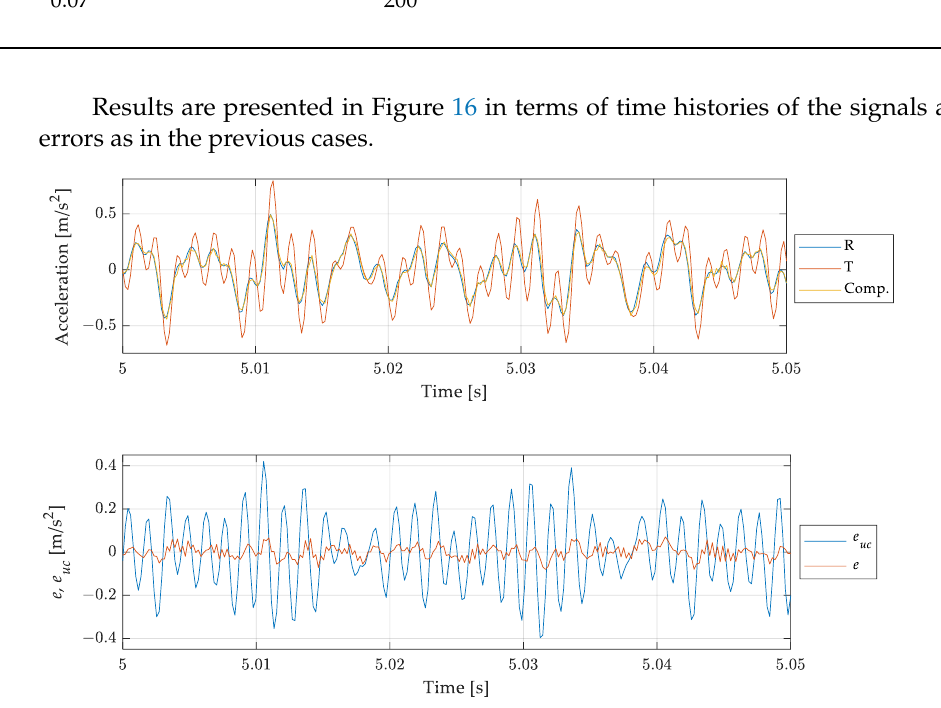
Figure 16. Test case 3: multicomponent signal. Comparison of the measurand with the (uncompen- sated) scaled instrument indication and the compensated measurement result. Short time histories ( top ) and errors for uncompensated 𝑒 𝑢𝑐 and compensated result e ( bottom ).